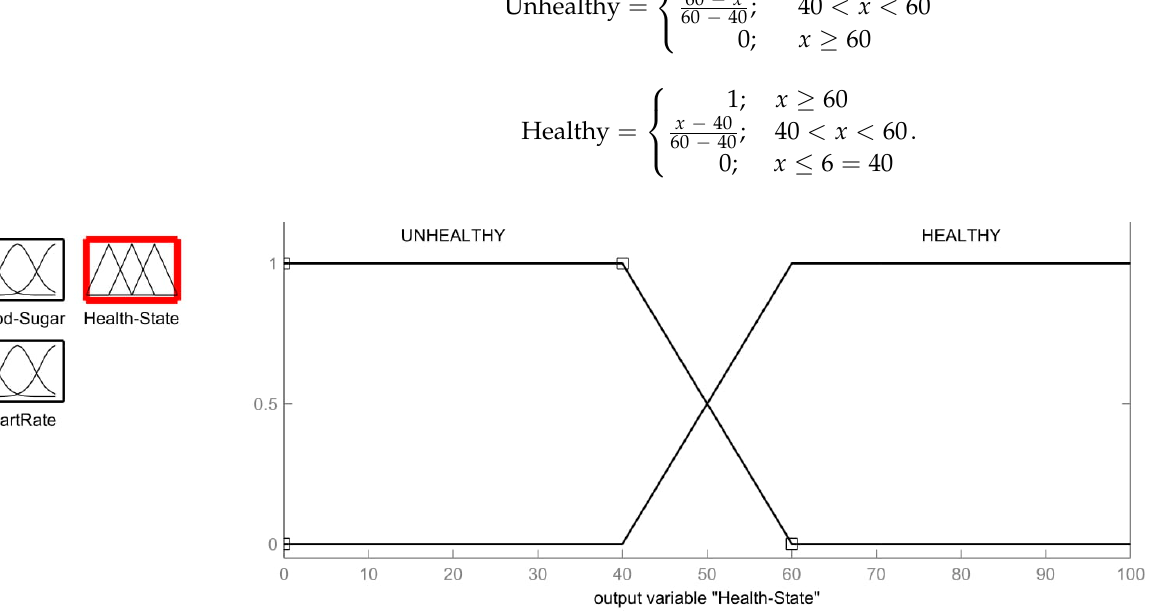
Figure 5. Membership function for Output Health State.